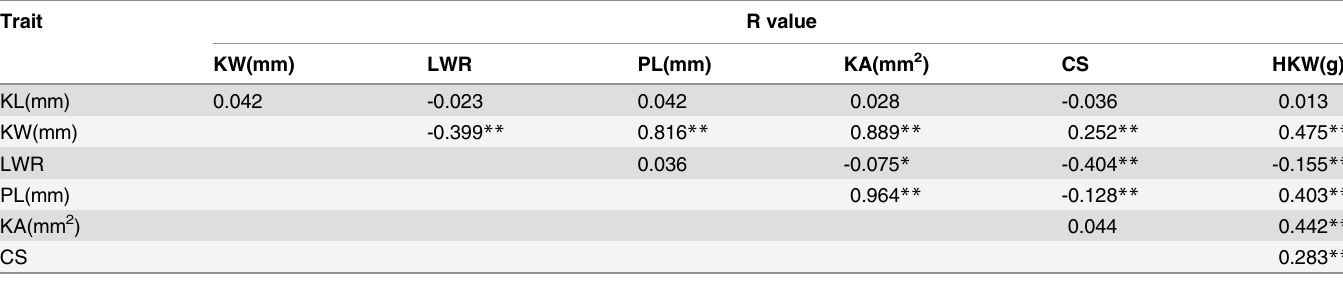
Table 3. The Pearson ’ s R correlation values among KSRTs, and between KSRTs and HKW. Trait R